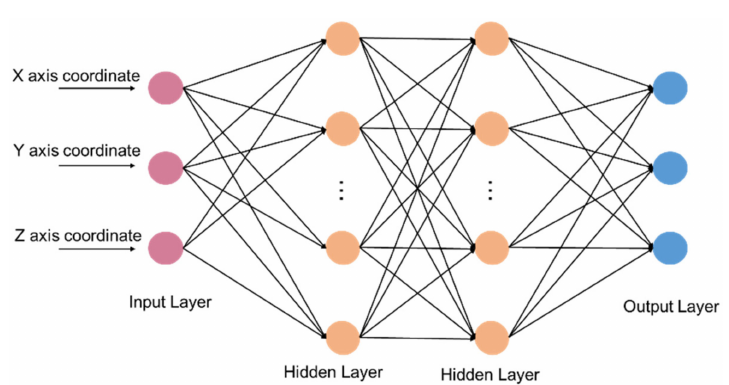
Figure 4. Multilayer perceptron model